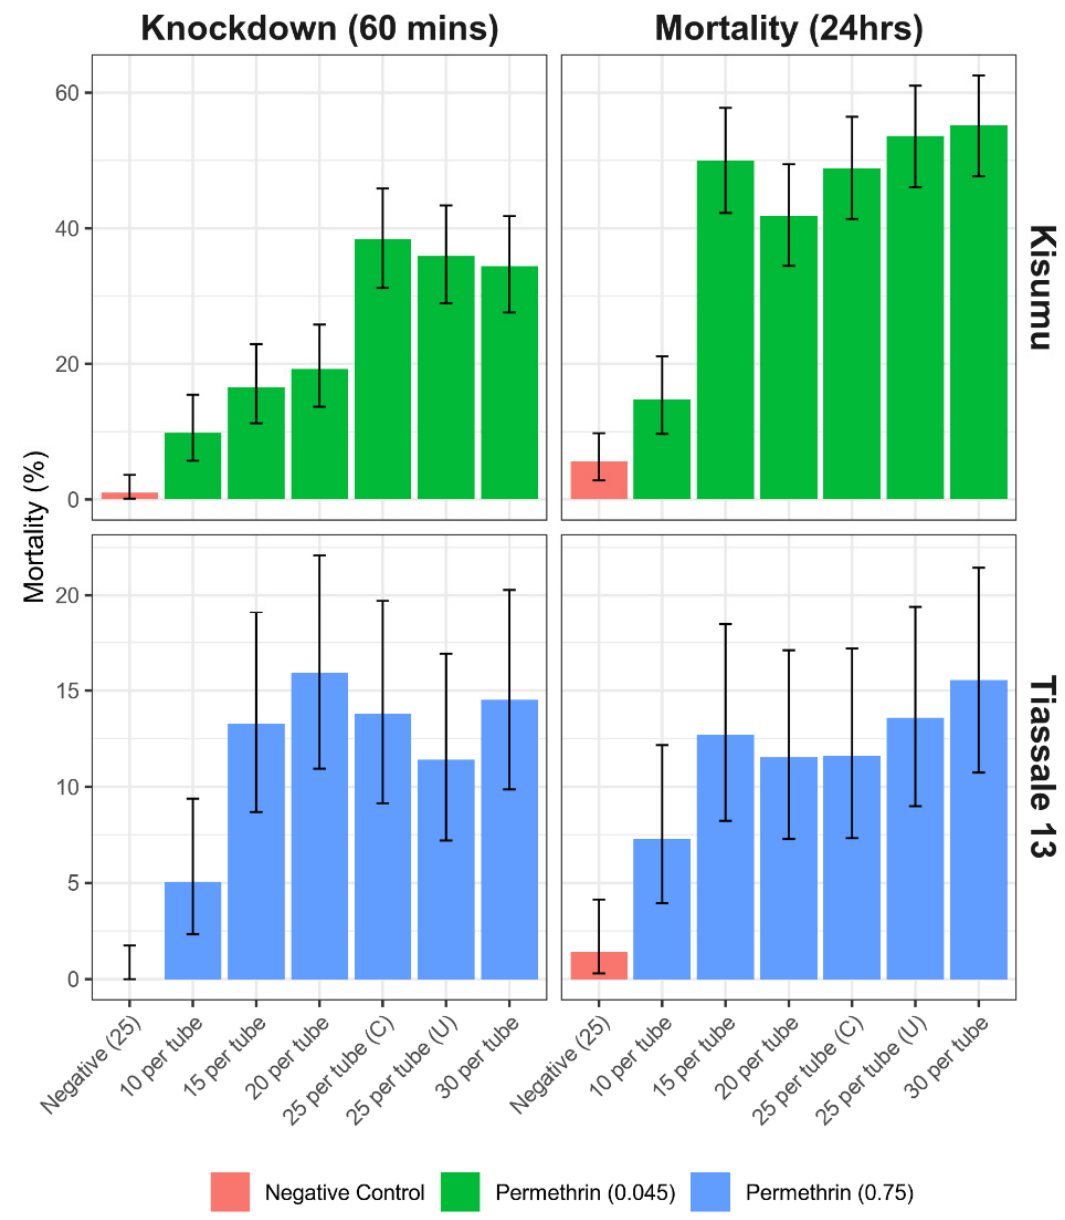
Figure 6. Bioassay data looking at the number of mosquitoes used in testing may impact the result of standardized bioassay testing for an Anopheles gambiae susceptible Kisumu strain and a resistant Tiassalé 13 strain. A total of 25 per tube (C) had the top of the tube covered during exposure, while 25 per tube (U) had the same conditions as the other tubes. Error bars equate to the 95% confidence intervals of the proportion.